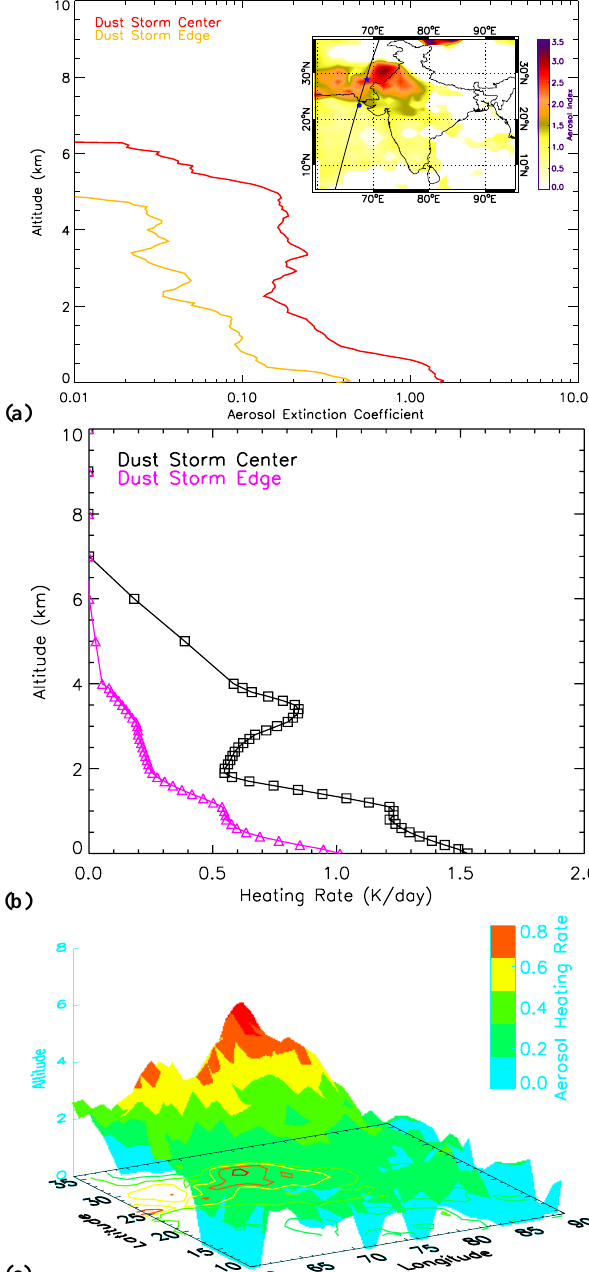
Fig. 2. (a) vertical profiles of AOD on 8 May 2007. Solid red lines show the AOD profiles at the center of the dust storm while the yellow line shows the AOD profiles at the edge of the dust storm. (b) Heating rates caused by the dust storm layer at center (black lines) and at the edge (pink lines) of the dust storm layer and (c) a 3-D plot showing the warming area with